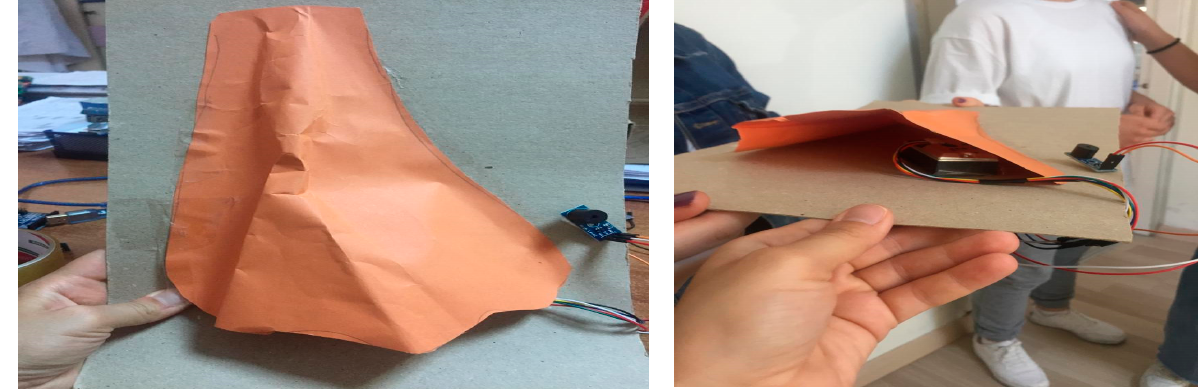
Figure 4. Nose model with a dust sensor.